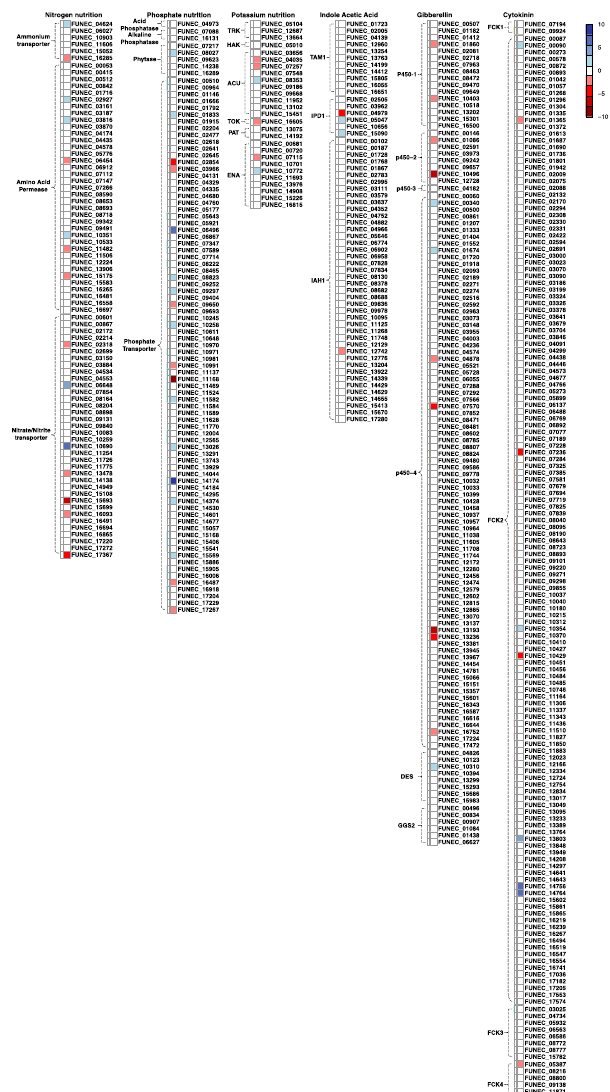
Figure 5. Plant growth-promoting genes of EC4 and their expression when in contact with cranberry plant roots. Top right, color code of the degree of differential expression, with numbers indicating the log2-fold change. Square color-filled boxes show differential expression for each gene. Genes are categorized into classes by dotted parentheses. Abbreviations of genes categories are: